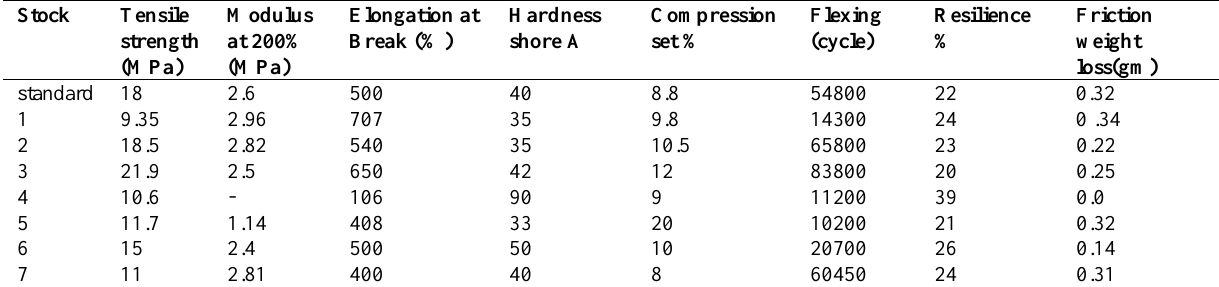
Mechanical Tests Results.